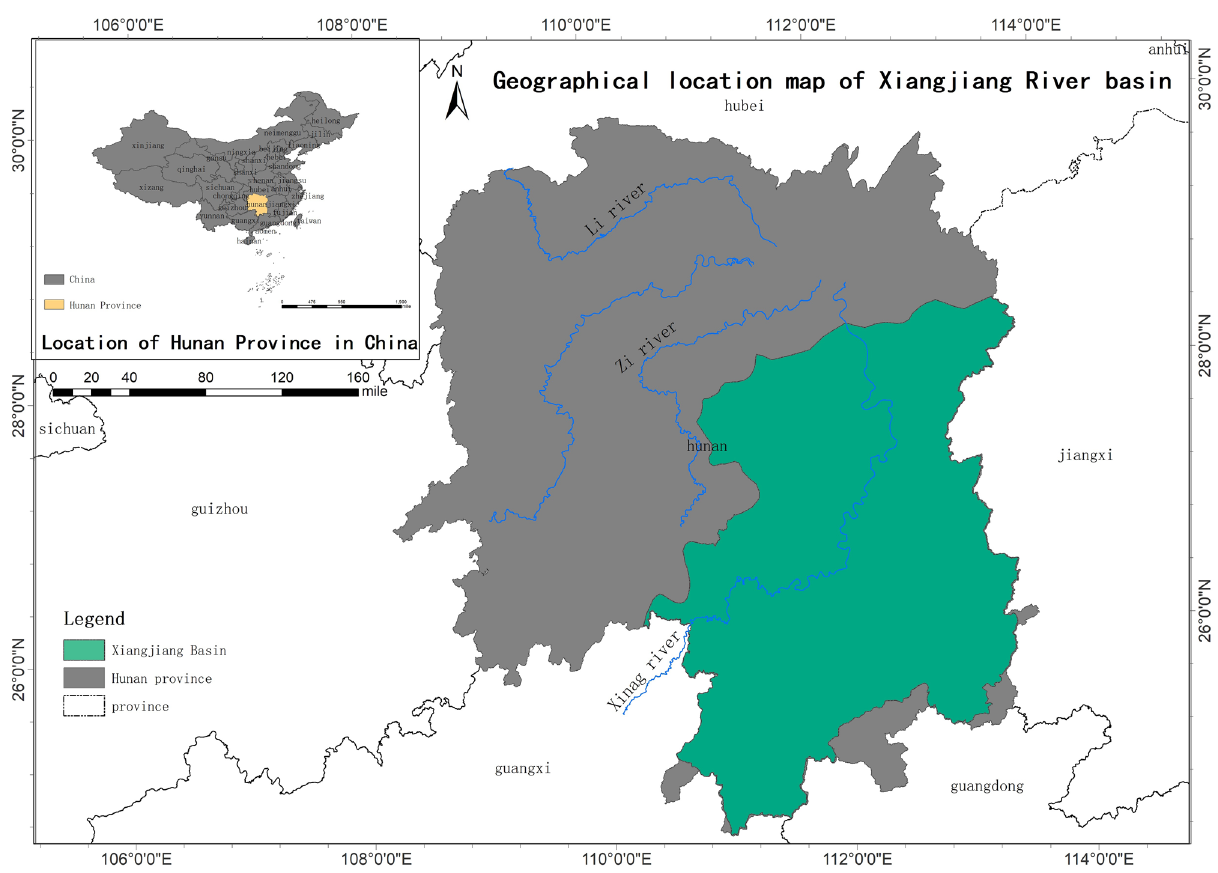
Figure 1. Location map of hunan section of the Xiangjiang River Basin.